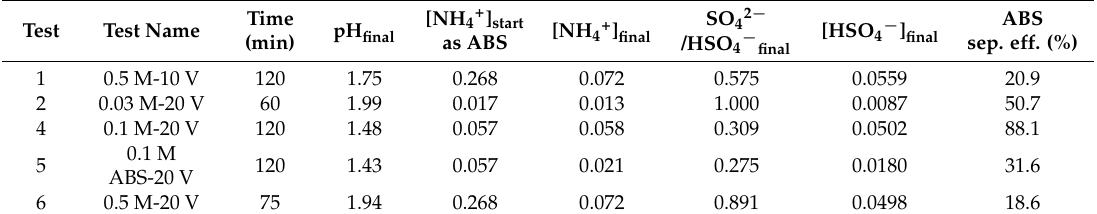
Table 3. ABS separation efficiency at the end of every test. Concentrations are in mol/dm 3 .